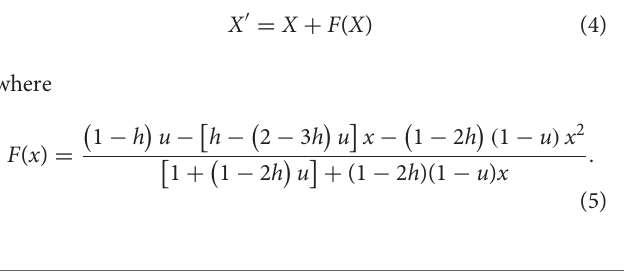
as X , and use X ′ to denote its value in the following